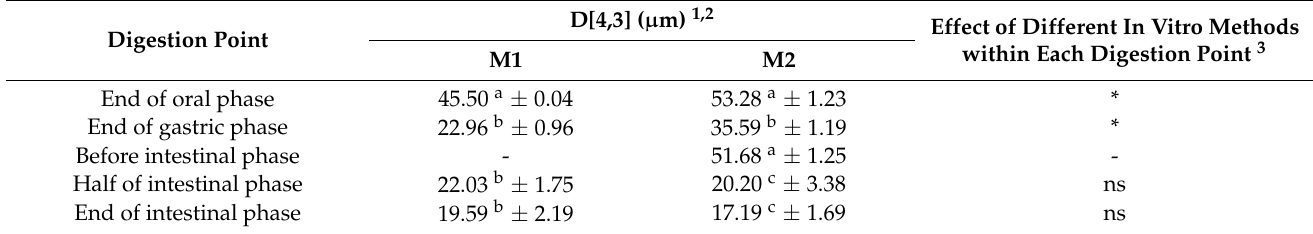
Table 2. Volume weighted mean (D[4,3]) of commercial broiler breasts (CB) digested by method 1 (M1) and method 2 (M2) 2 and collected at different digestion